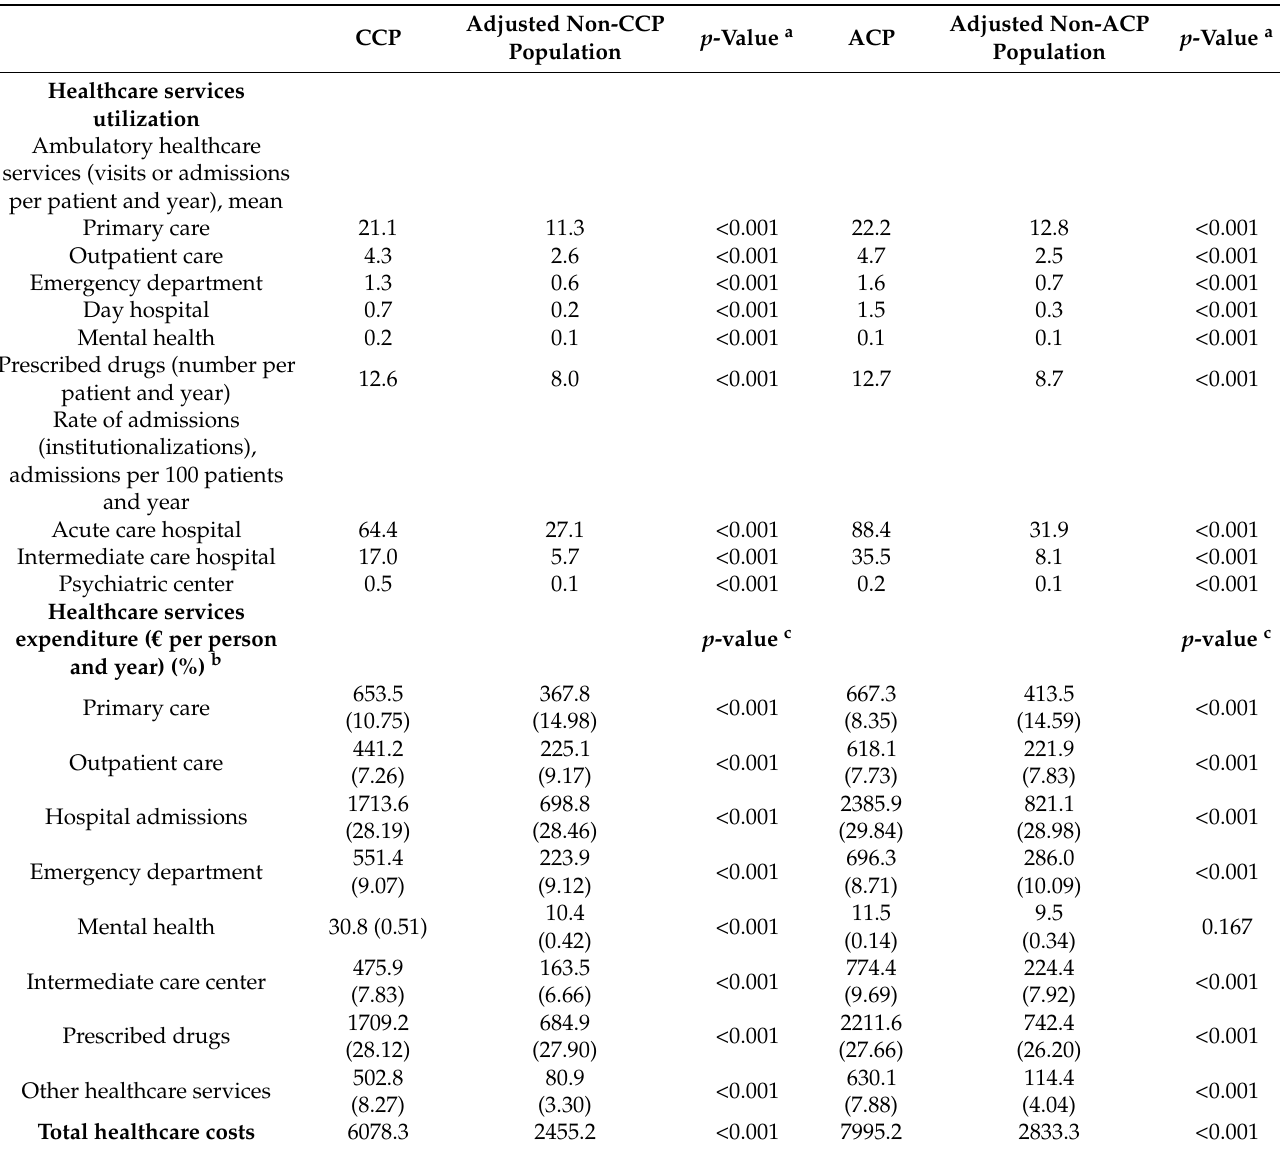
Table 6. Utilization of healthcare services by complex chronic (CCPs) and advanced chronic (ACPs) patients and their corre- sponding non-CCP and non-ACP populations adjusted by age, sex, and annual income, and their associated expenditures (year